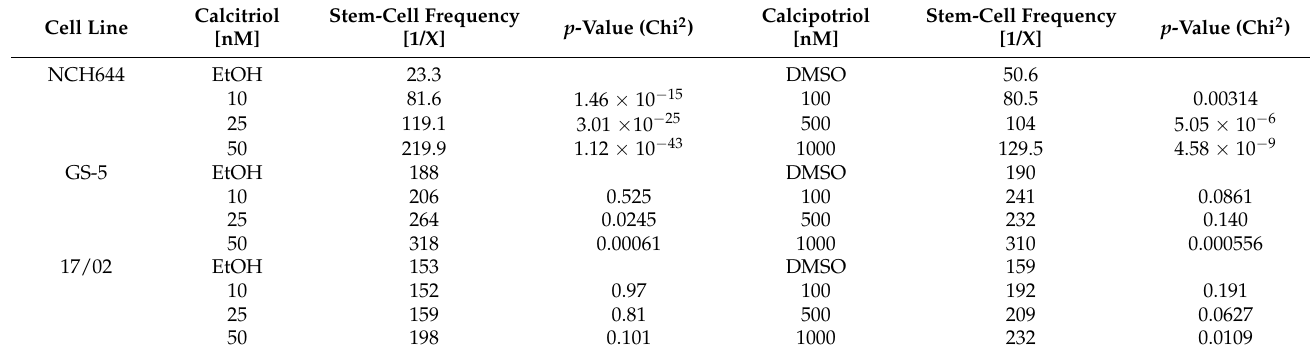
Table 1. Calculated stem-cell frequencies, as determined using ELDA [31], of the GSCs NCH644, GS-5 and 17/02, 7 days after treatment with calcitriol, calcipotriol or solvent (EtOH, DMSO, respectively), as indicated.